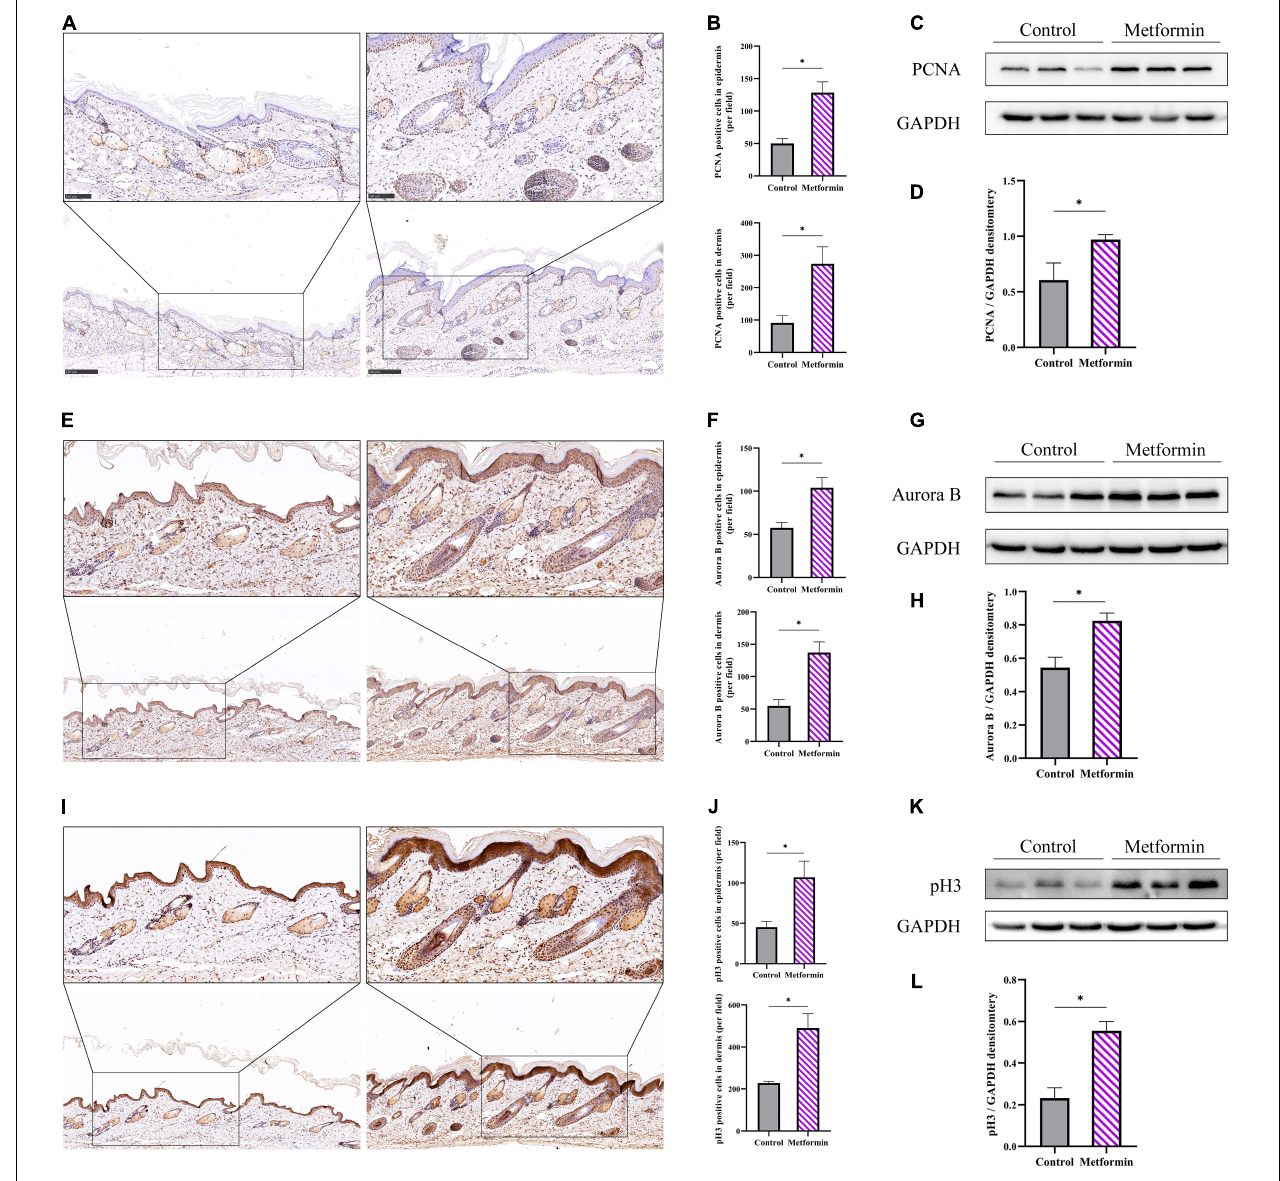
FIGURE 5 | Cell proliferation in the mechanically stretched skin. Immunohistochemistry (IHC) staining of PCNA (A) , Aurora B (E) , and pH3 (I) in mechanically stretched skin. Proliferative cells were mainly located in the basal layer of the epidermis and near the dermal hair follicles. More proliferating PCNA+ (B) , Aurora B+ (F) , and pH3+ (J) cells were present in both the epidermis and dermis of metformin-treated skin. Western blotting was used to detect the protein expression of PCNA (C) , Aurora B (G) , and pH3 (K) , and increased expression of PCNA (D) , Aurora B (H) , and pH3 (L) was observed in the metformin-treated group. ∗ p <